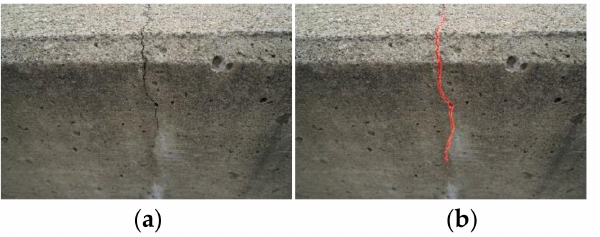
Figure 10. Comparison of original DeepLabv3+ and Dense-DeepLabv3+ crack segmentation results. ( a ) original image ( b )